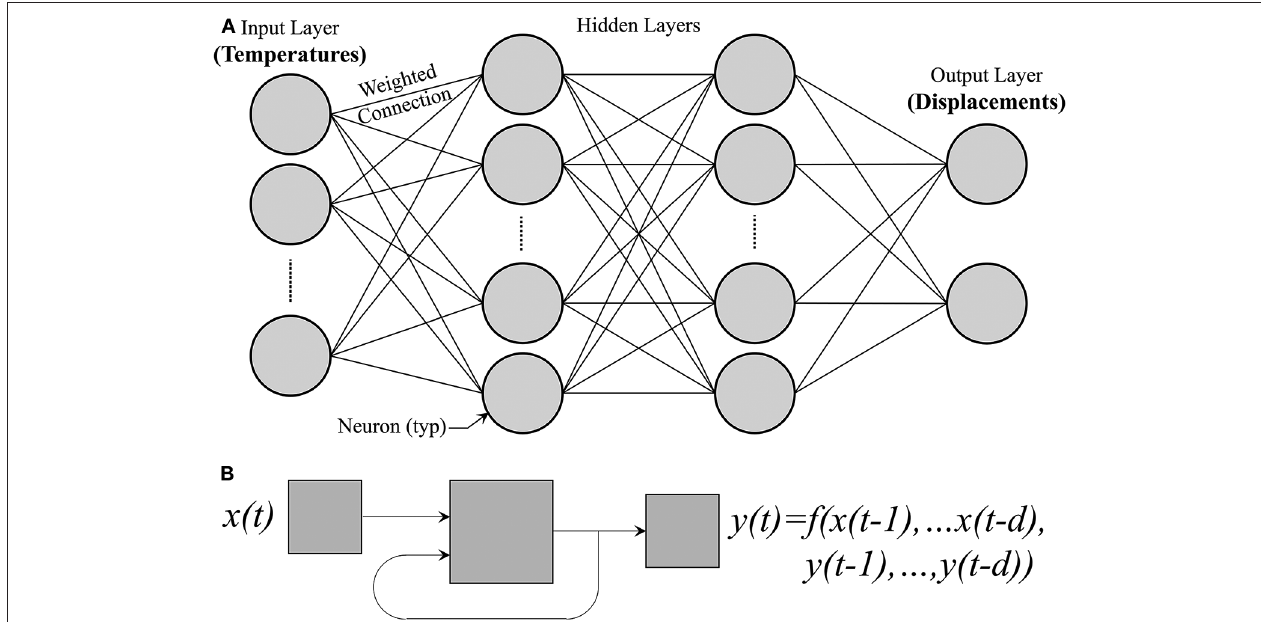
FIGURE 4 | (A) Illustration of the multi-layer neural network and (B) illustration of the NARX